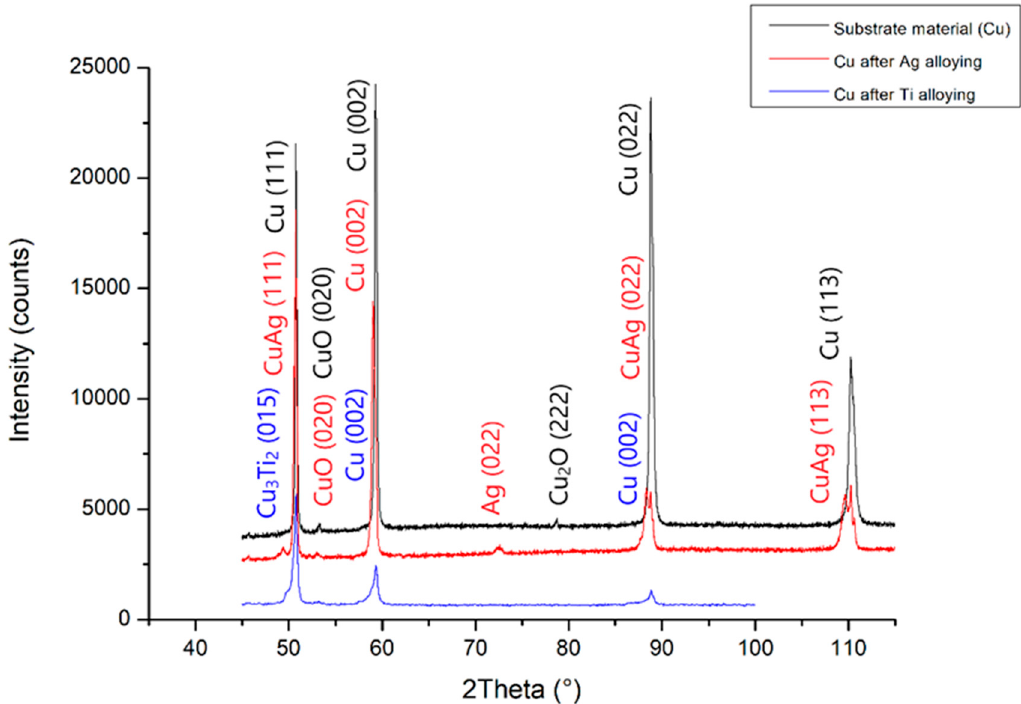
Figure 11. The microstructure of the heat affected zone (HAZ) zone with the recrystallization area, #A, marked. Table 3. Interplanar distances of the laser-alloyed copper.